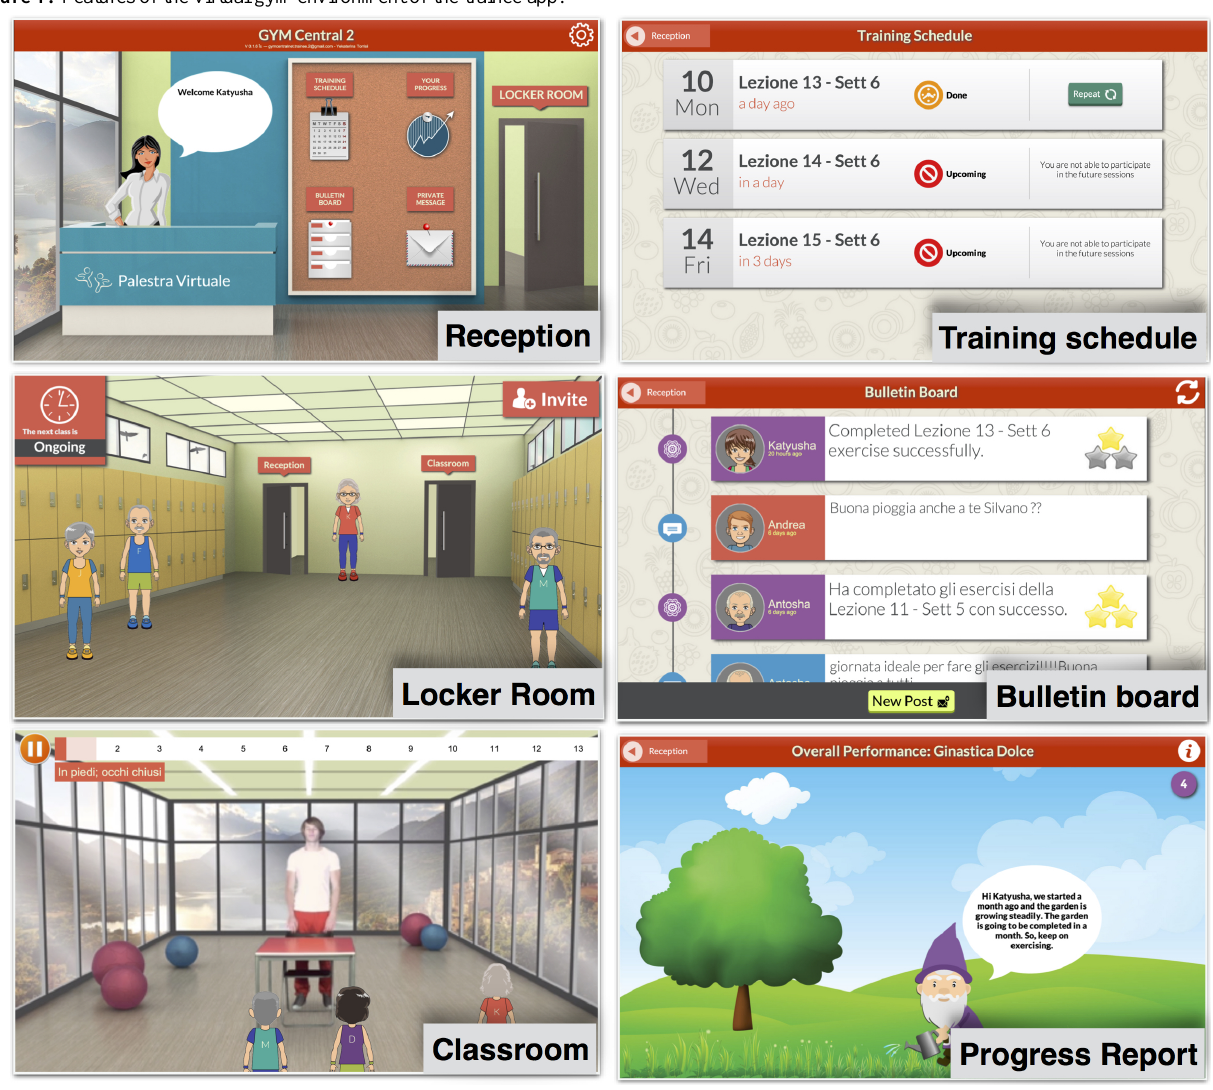
Figure 1. Features of the virtual gym environment of the trainee